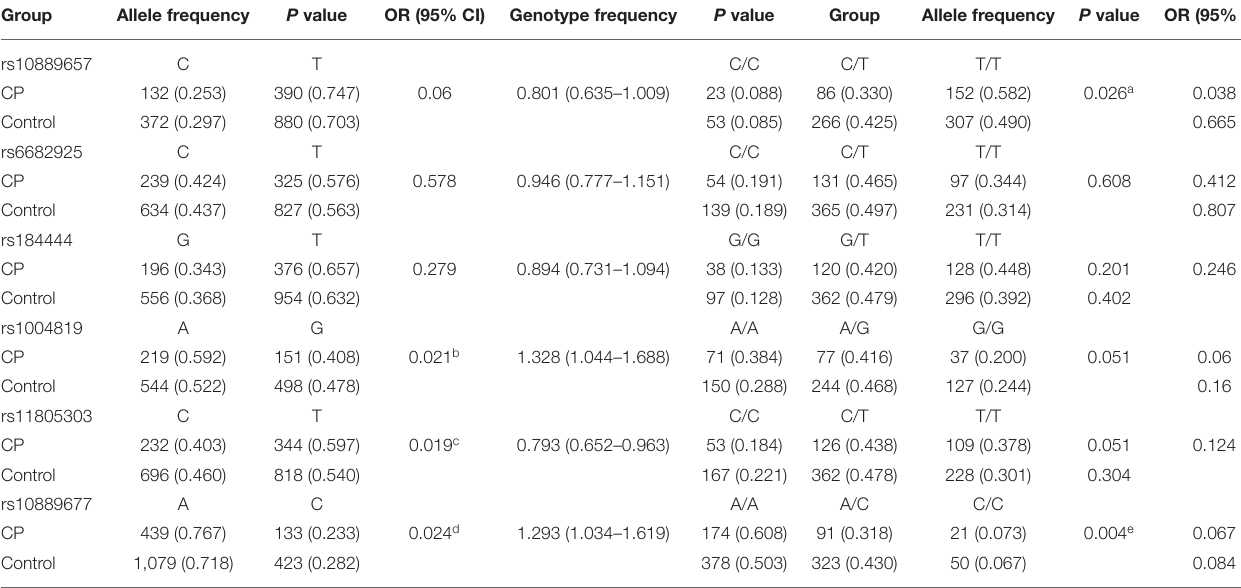
TABLE 4 | Allele and genotype frequencies of IL-23R in CP with GDD and the control group. Group Allele frequency P value OR (95% CI) Genotype frequency P value Group Allele frequency P value OR (95% CI)